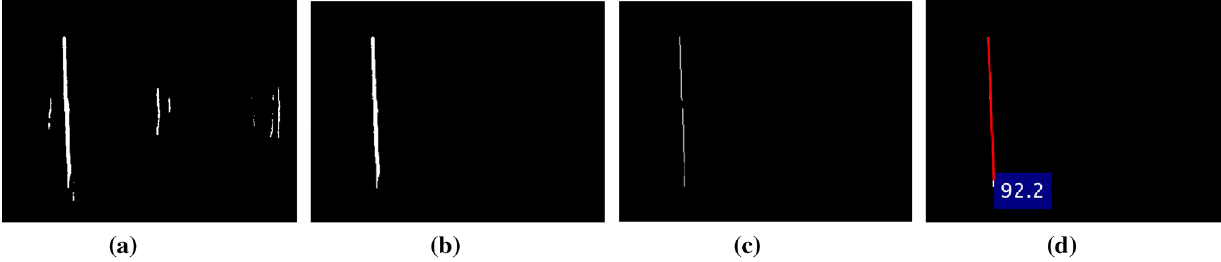
Fig. 3 Detected utility pole region refine and angle calculation. a The pole regions segmented from an unmanned aerial vehicle (UAV) image by SegNet; b the extracted pole region from ( a ) after the area